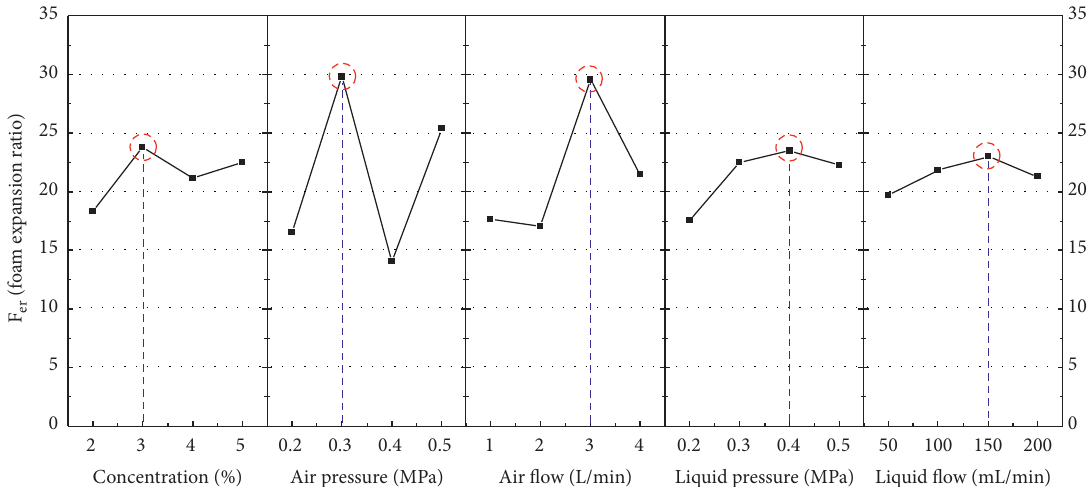
Figure 12: Effect of foaming parameters on foam expansion ratio.